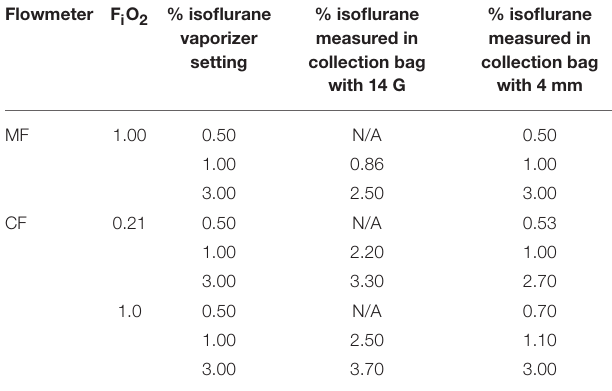
TABLE 3 | Mean isoflurane concentration obtained by a 4-min collection in a bag at different dial setting of the isoflurane vaporizer under different settings